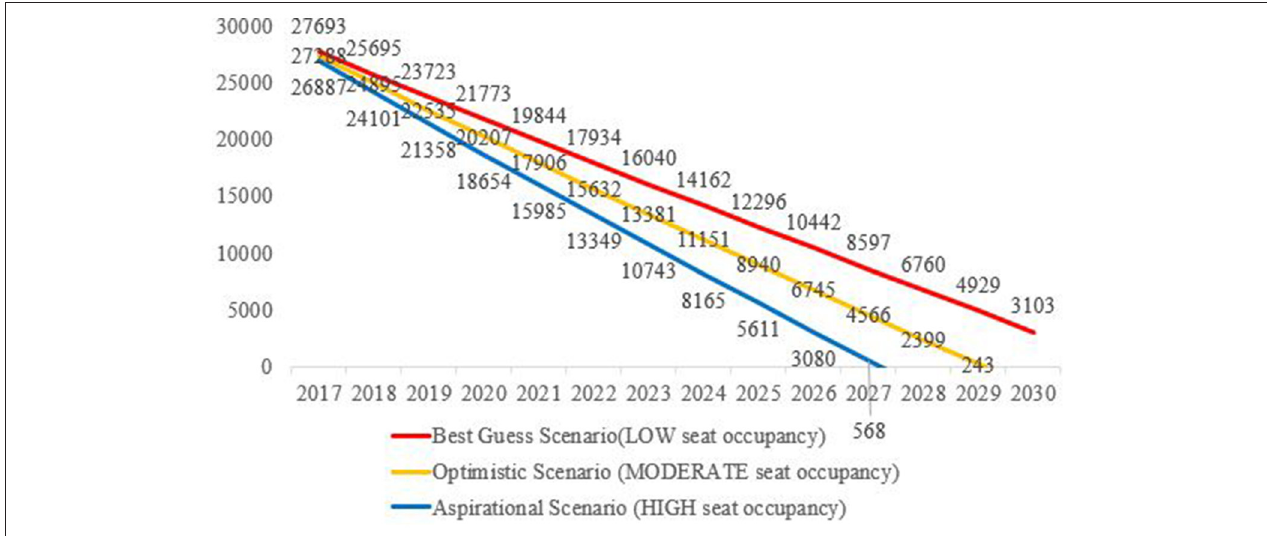
FIGURE 2 | Gap in the number of HMPs calculated against a normative need of 2.97 HMPs per 100,000